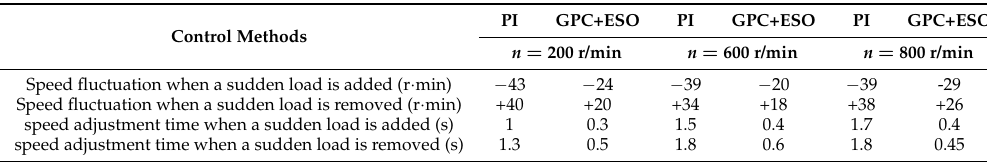
Figure 9. Experimental speed curves when a sudden load is added or removed. ( a ) n = 200 r/min; ( b ) n = 600 r/min and ( c ) n = 800 r/min. Table 2. Comparisons of disturbance rejection